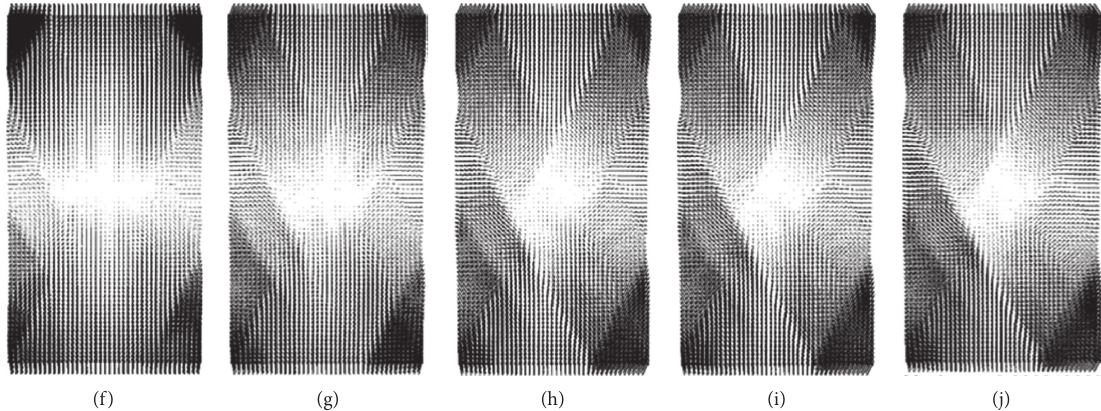
Figure 15: Displacement evolvement at different stress level in simulated triaxial compression test under confining pressure of 20MPa.